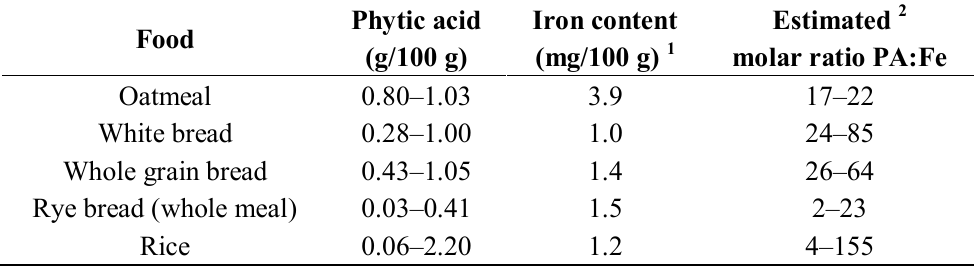
Table 1. Iron [45] and phytic acid (PA) content [43] in common cereal